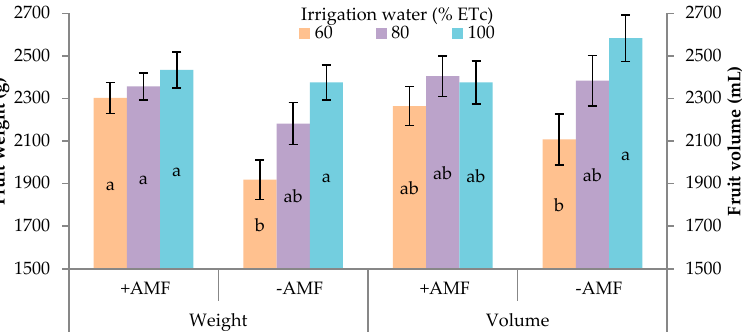
Figure 10. Effect of irrigation treatments and plant inoculation with arbuscular mycorrhizal fungi (AMF) on melon fruit weight and volume during two years of experiments (for each interaction,